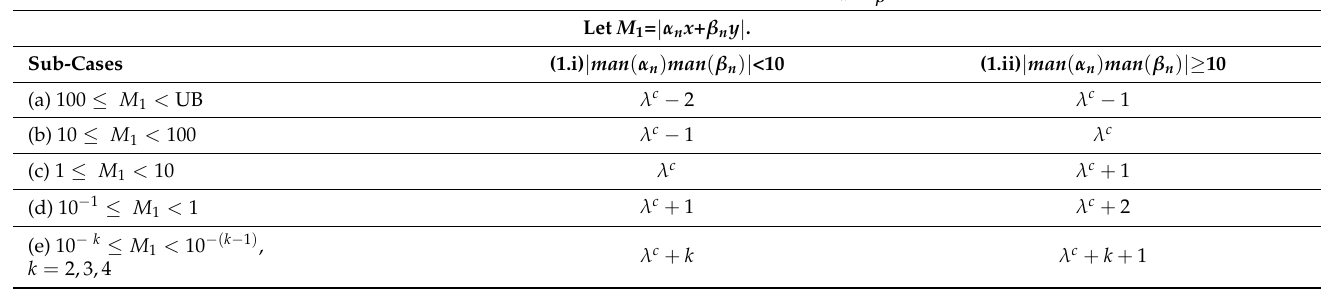
= λ c . The first column under the title “sub-cases”, the eventual values of Table 1. This refers to Case 1, with λ c α = λ c β M 1 = | α n x + β n y | are shown. In Line 3, in the right of the same title, the possible values of the product | man ( α n ) man ( β n ) | are presented. The obtained number of correct decimal digits (c. d. d.) of product γ n = a n β n is shown in bold in each corresponding